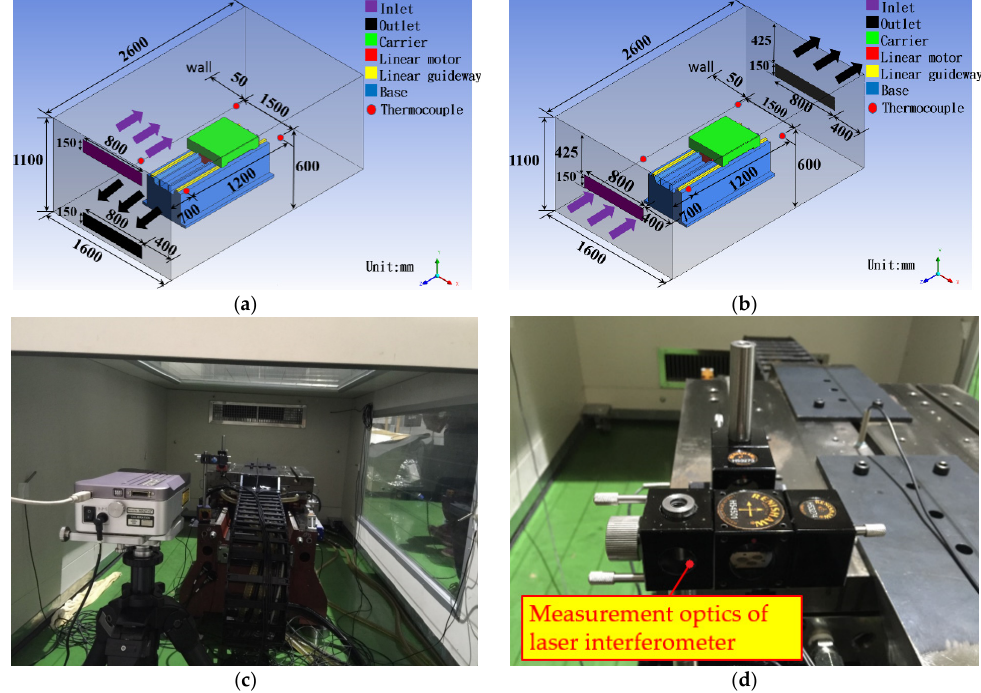
Figure 2. The relative position of the air inlet and outlet in the environmental chamber during the numerical study and the experimental setup: ( a ) the air inlet and outlet are located on the same side of the chamber; ( b ) the air inlet and outlet are located on opposite sides of the walls; ( c ) image of the experimental setup; ( d ) Renishaw laser interferometer. The red circles in figures ( a , b ) represent the corresponding locations of the thermocouples in the experimental study.